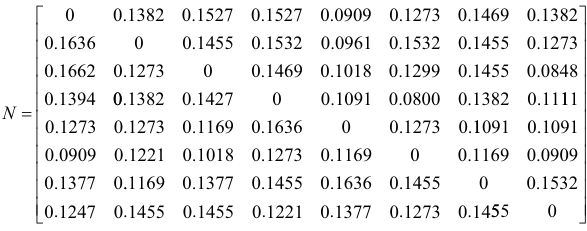
matrix N ( g = 1 27 5/ .